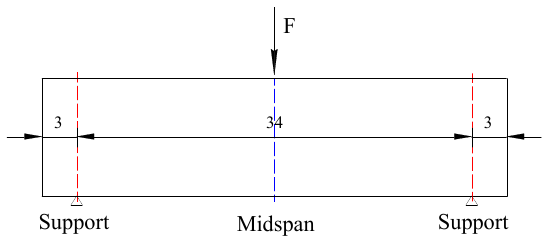
Figure 4. Sketch of three-point bending test (unit: cm).